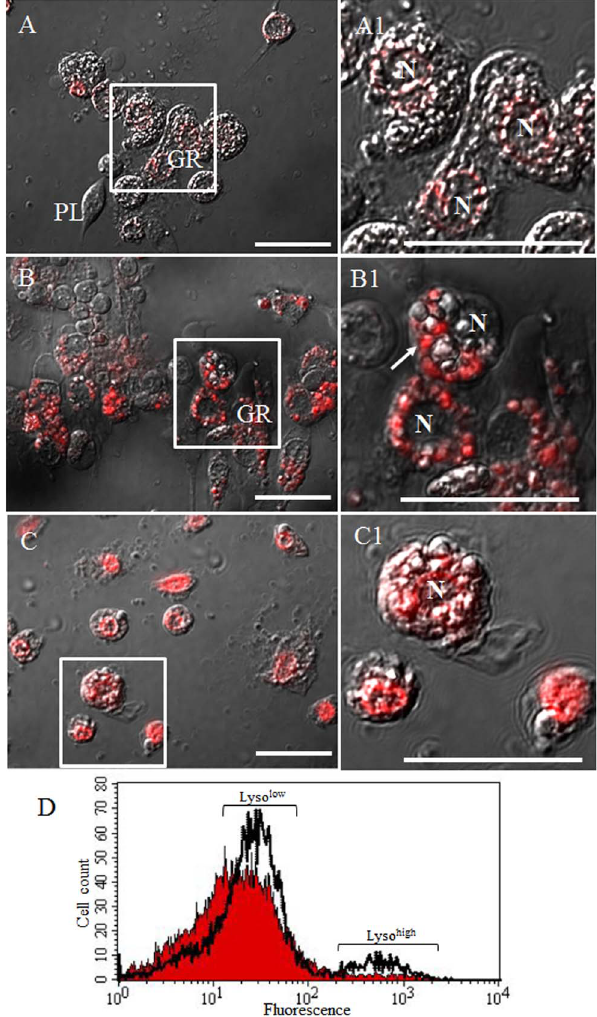
Figure 3. LysoTracker Red labeling of lysosomes in granulo- cytes and flow cytometric analysis after non-florescence carboxylate-modified polystyrene latex beads injection. (A and A1) 0 h post injection, (B and B1) 12 h post injection, and (C and C1) 48 h post injection, and (D) flow cytometric analysis at 12 h post injection. Data shows representative histogram overlays (filled histo- gram, 0 h post injection; and transparent histogram, 12 h post injection). The red filled histogram and transparent histogram indicate naı¨ve and challenged larvae, respectively. Based on the red fluorescence intensity, two peaks were identified, Lyso low and Lyso high . In the Lyso low region, approximately 66.68% of naı¨ve were increased to 77.44% at 12 h post infection. In addition, 1.93% of hemocytes of naı¨ve were increased to 7.73% of hemocytes at 12 h post infection in the Lyso high region. A1, B1, and C1 indicate a higher magnification of the regions in inset of panel A, B, and C. Over 90% of granulocytes were strongly stained by LysoTracker and the staining was especially prominent in their highly polymorphic vacuoles. GR, granulocytes; N, nuclei, Scale bar=20 m m. 11.40% of granulocytes at 24 h post injection and 1.39% of granulocytes at 0 h post injection, were in the LC high region (Fig. 6A2 and 6E2). Approximately 10% of GFP-stained hemo- cytes were increased in the LC low region at 24 h post injection. Then, at 48 and 96 h post injection, LC3 accumulation in granulocytes decreased gradually (Fig. 6F2 and 6G2). Fig. 6H1